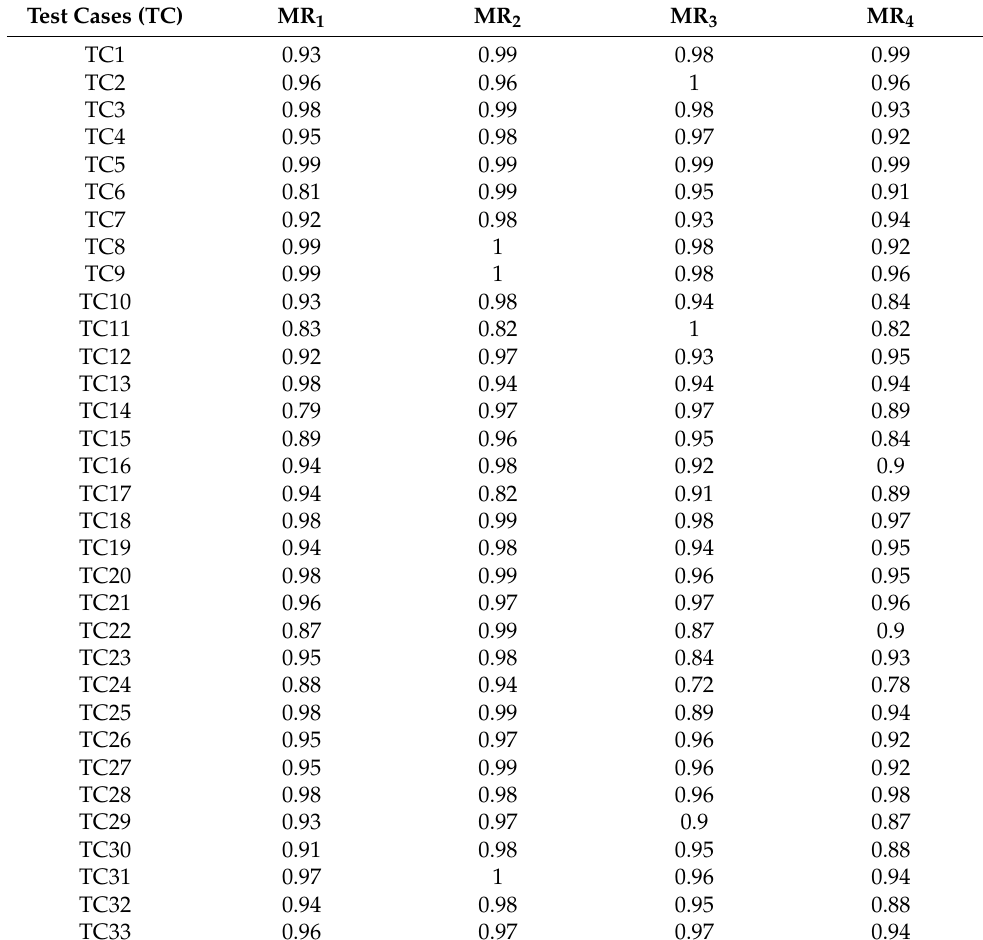
Table 4. SSIM value of T1-weighted